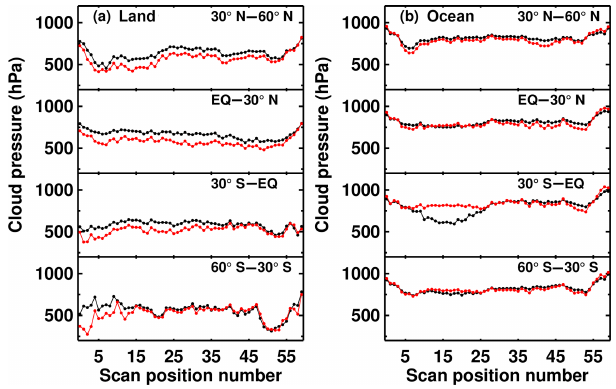
Figure 15. Cross-track dependence of OCPs retrieved with GLER (black) and those retrieved with climatological LER (red) for 13 November